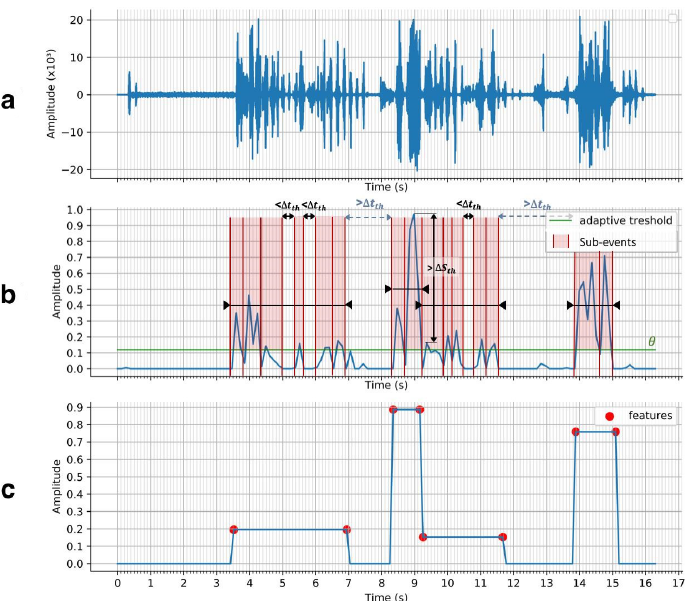
Figure 7. Representation of the sound signal at three main stages during the sound event detection process: ( a ) raw sound signal, ( b ) pre-processed signal, ( c ) sound event features after event